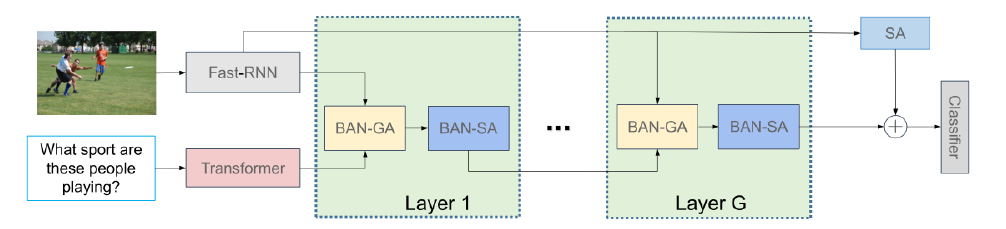
Figure 2. Overview of the proposed model. A deep neural network implements a joint embedding of the question feature encoded by BERT and an image feature encoded by Faster-RCNN [27]. BAN-GA denotes Multi-glimpse Bilinear Guided-Attention Network; BAN-SA denotes Multi-glimpse Bilinear Self-Attention Network; and SA represents Multi-head